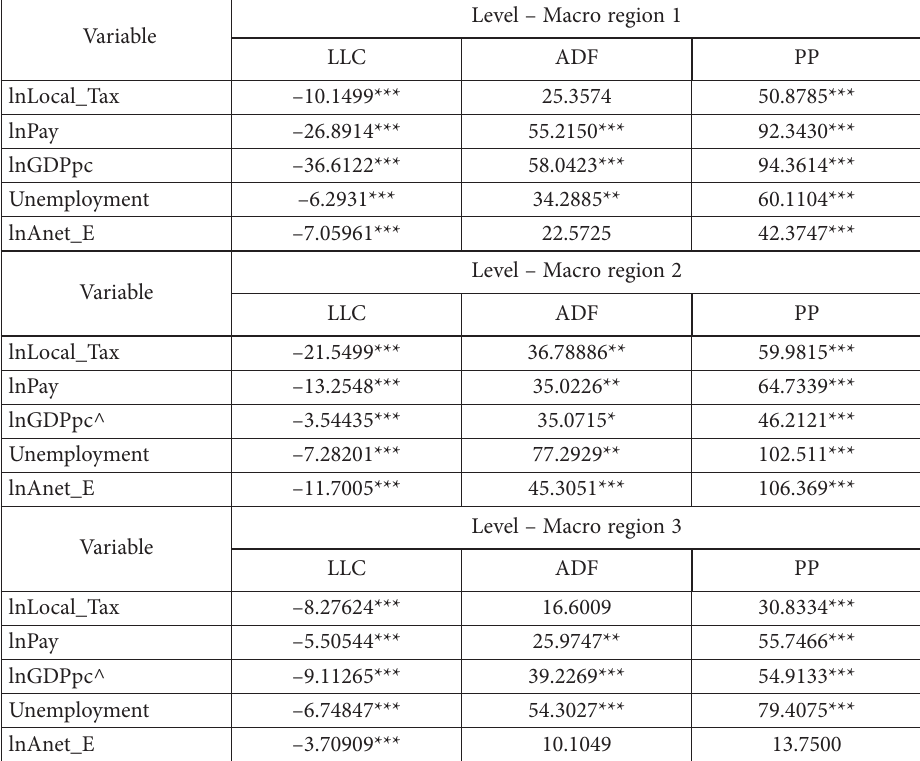
Table 3. Panel unit root tests